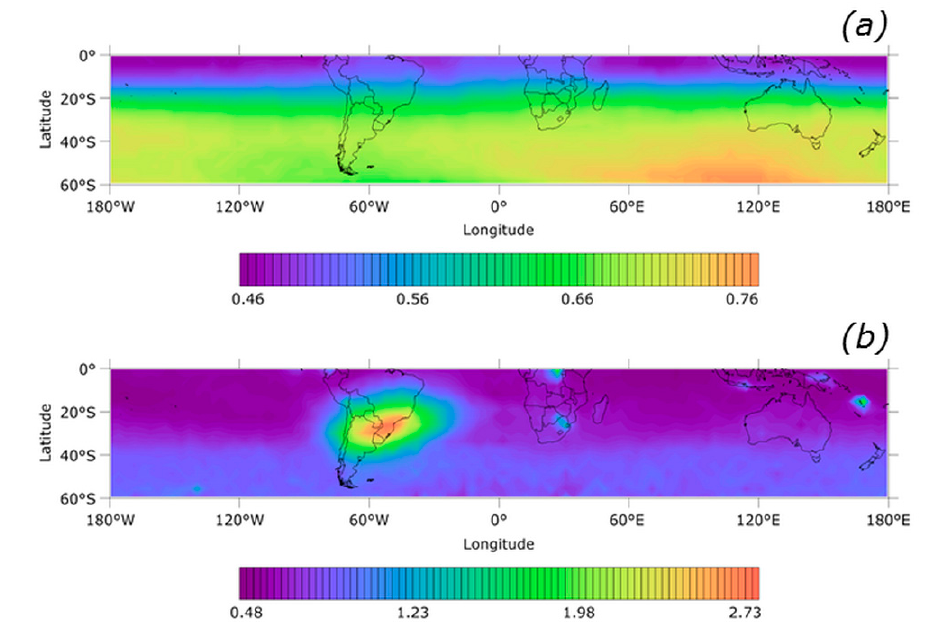
Figure 1. Mean concentrations for the quarterly (Q) time series over the study period for ( a ) NO 2 in the stratospheric (Strat) and ( b ) SO 2 in the planetary boundary layer (PBL). Values expressed in DU. The prominent mean concentrations in southern Brazil (BRA) in ( b ) are related to the South Atlantic Anomaly (SAA).